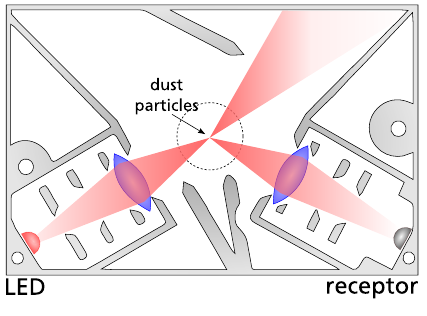
Figure 1. In light-scattering sensors (a.k.a. nephelometers), light is emitted into a measurement chamber. If there are particles present, the light is refracted and collected by a